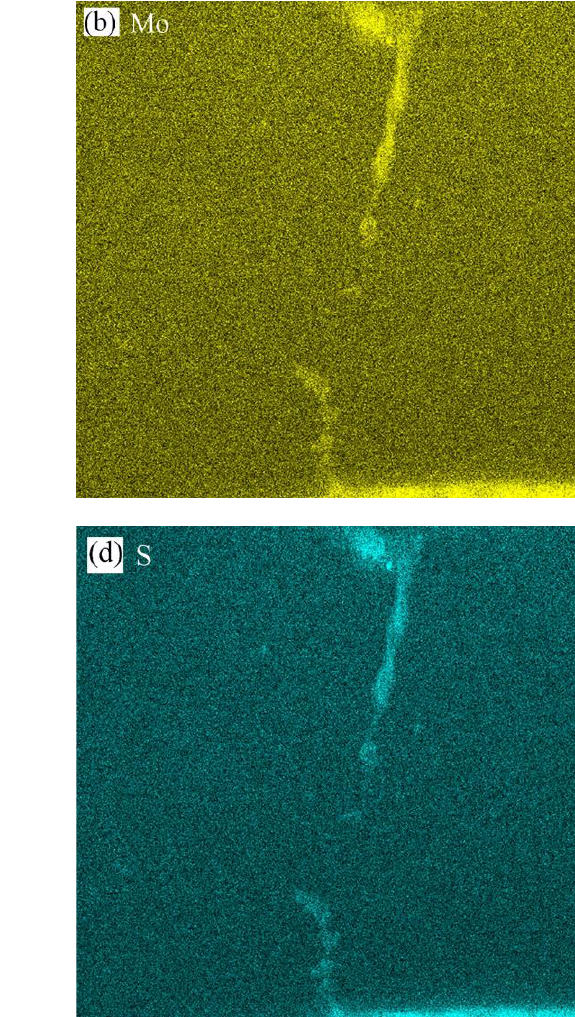
Figure 19. Microstructure and chemical composition distribution of location C: ( a ) IPF X; ( b ) band